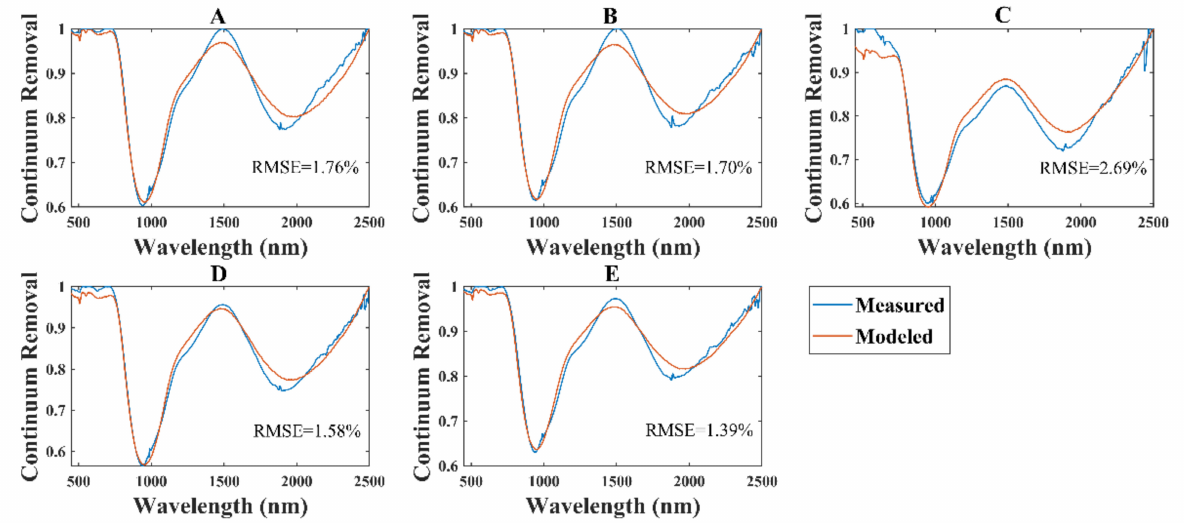
Figure 10. Comparisons between the measured point spectra ( A – E ) (in blue) and their modeled spectra (in red) of the NWA 8687 chip.